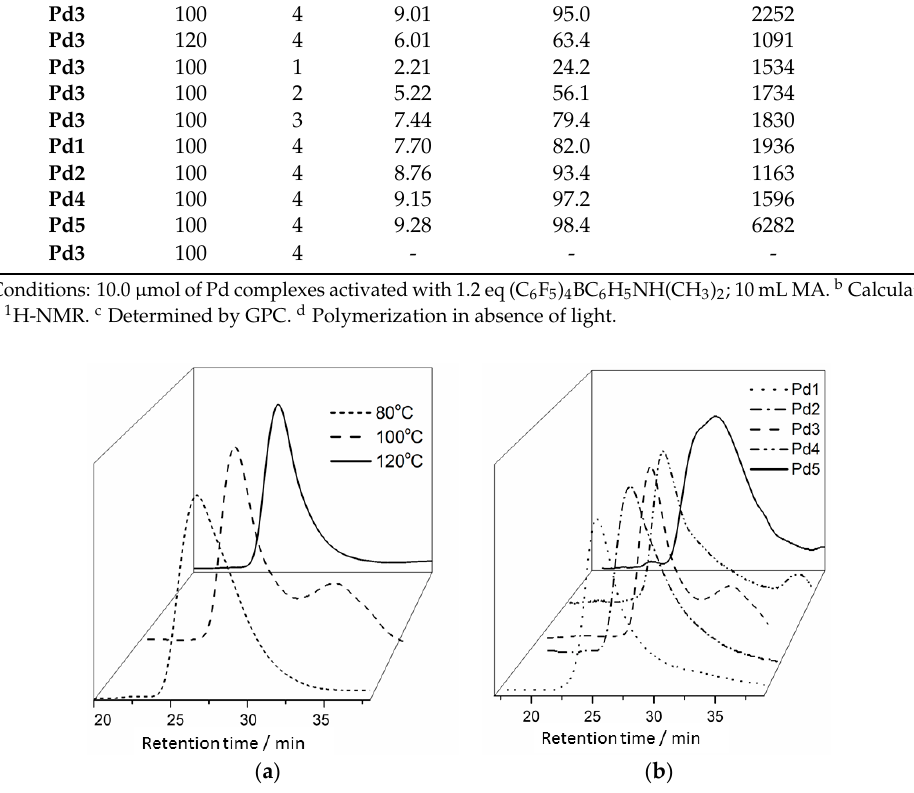
Figure 3. GPC traces of PMA produced by complex Pd3 at different polymerization temperature ( a ) and by different complexes Pd1 – Pd5 ( b ).